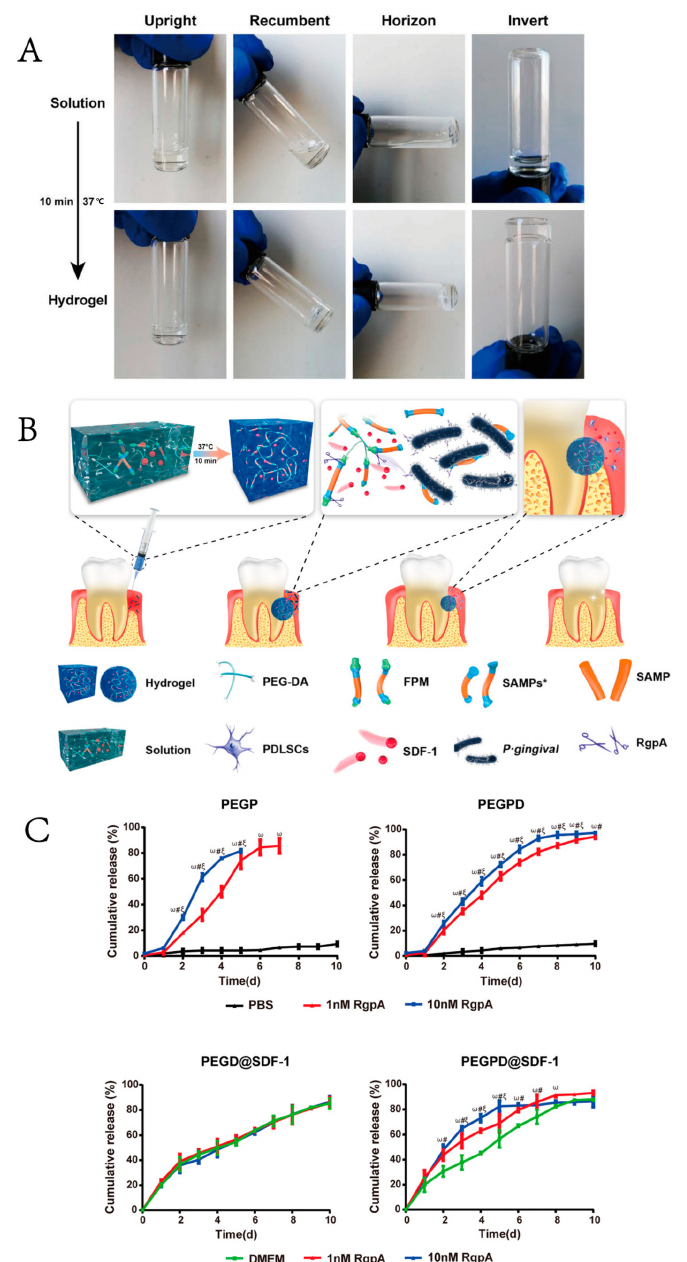
Figure 3. Schematic diagram of the gingipain-responsive thermosensitive hydrogel. ( A ) Photographs of the solution to hydrogel transition by placing the solution in a 37 ◦ C incubator for 10 min. ( B ) Preparation and application of the gingipain-responsive thermosensitive hydrogel. ( C ) Release curves of SAMP (upper) and SDF-1 in different hydrogels. Data are presented as the mean ± SD, n = 3. ω , p < 0.05 for the PBS/DMEM group vs. the 1 nM RgpA group. #, p < 0.05 for PBS/DMEM group vs. 10 nM RgpA group. ξ , p < 0.05 for the 1 nM RgpA group vs. the 10 nM RgpA group. (PEG: polyethylene glycol; DA: diacrylate; FPM: functional peptide module; SDF-1: stromal cell derived factor-1; SAMP: short antimicrobial peptide; RgpA: gingipain R1 protein. Adapted with permission from [80], Copyright 2021 American Chemical